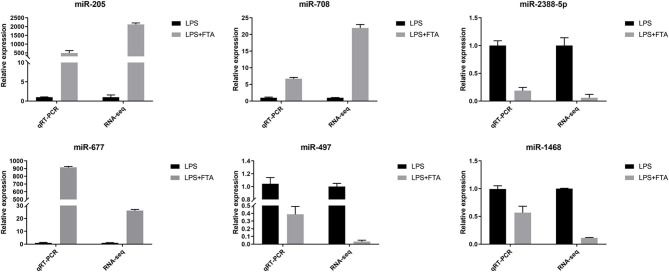
Validation of features of DEGs through qRT-PCR. The relative expression level of target miRNAs was calculated using the 2−ΔΔCt method. Data represent the mean ± SEM (n = 3).The Log2−fold change was the average log2−fold change between samples.